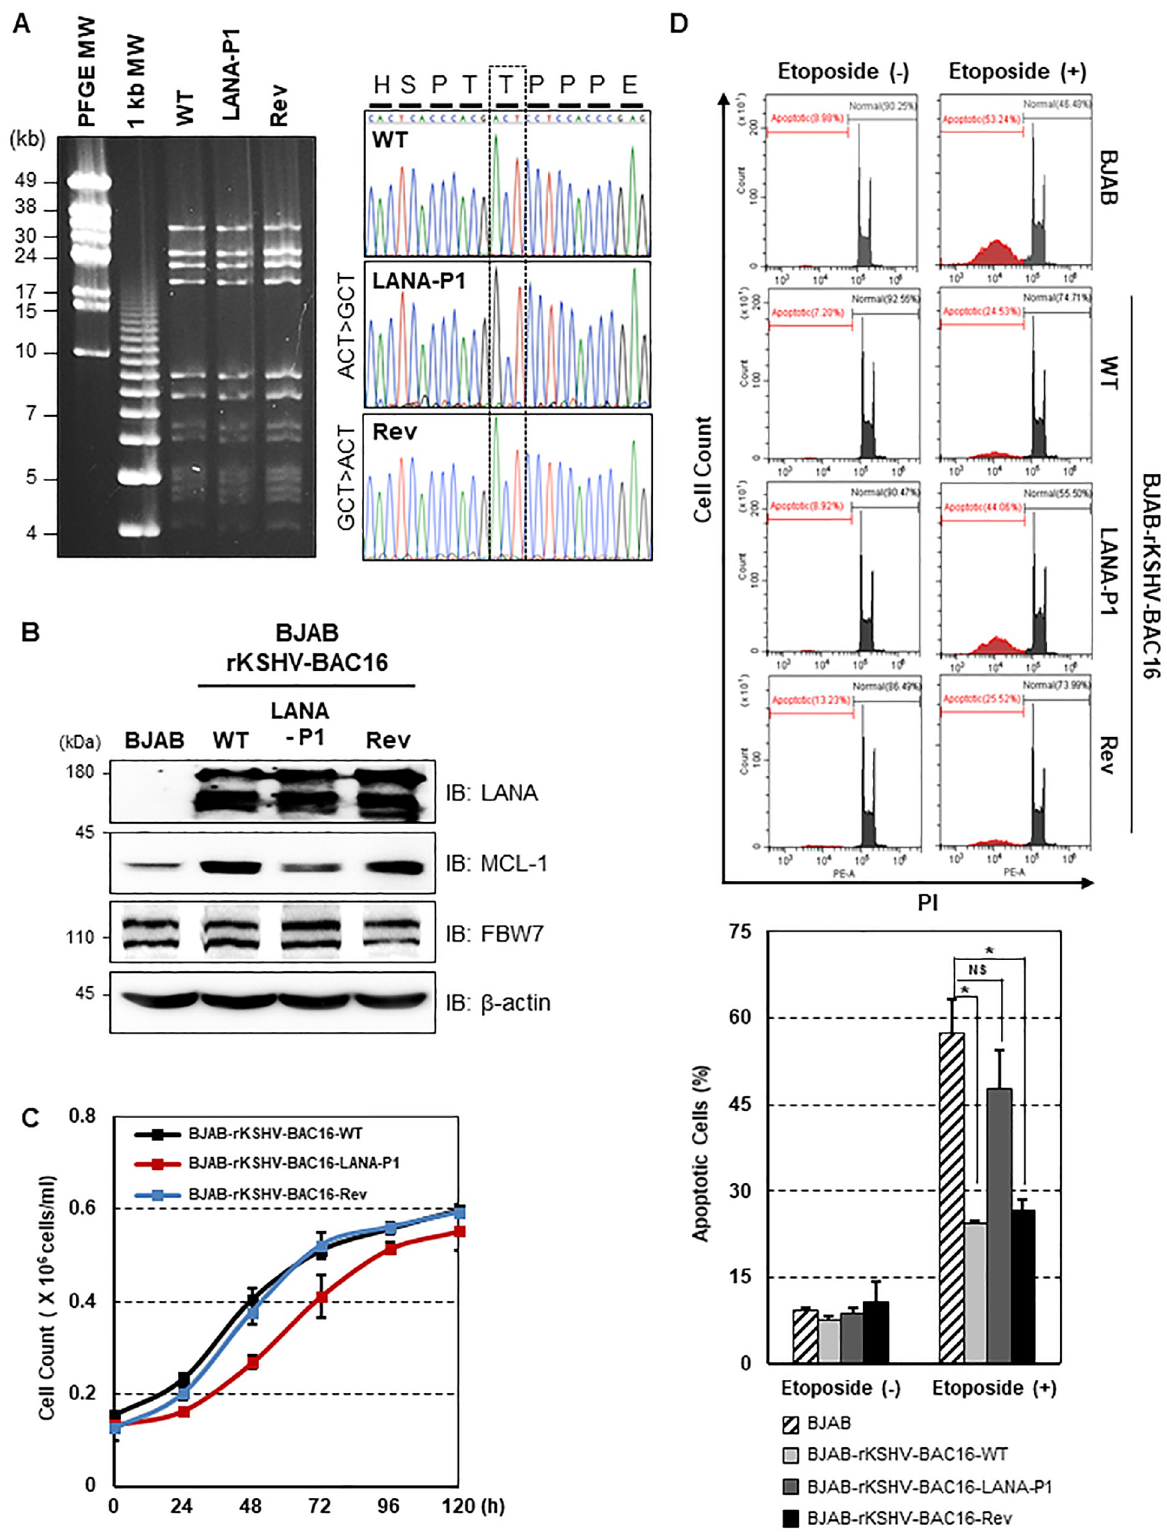
Fig 5. KSHV-infection induces the MCL-1 stabilization in BJAB cells. (A) (Left panel) BAC DNAs were digested with NheI restriction enzyme and subjected to PFGE analysis. (Right panel) BAC16 clones were confirmed by Sanger DNA sequencing. (B) WT, LANA-P1, Rev